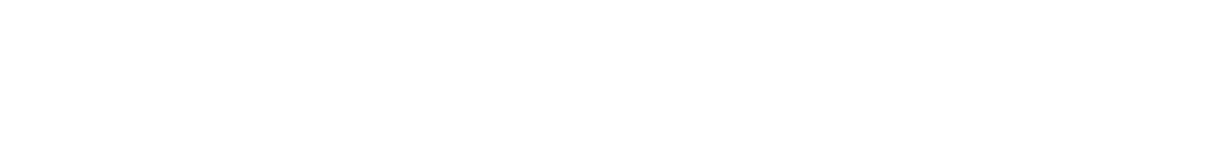
Frontiers in Bioengineering and Biotechnology |